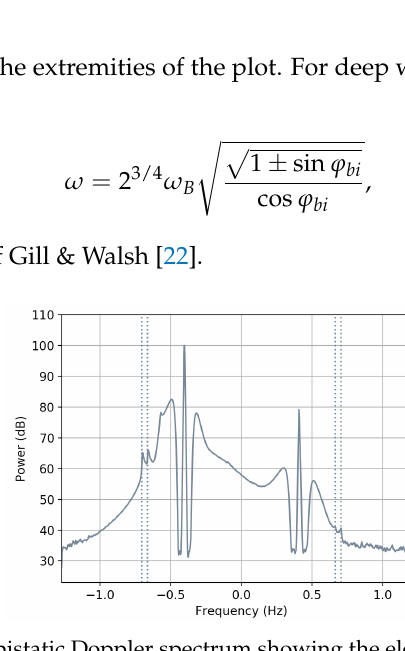
Figure 10. A simulated bistatic Doppler spectrum showing the electromagnetic